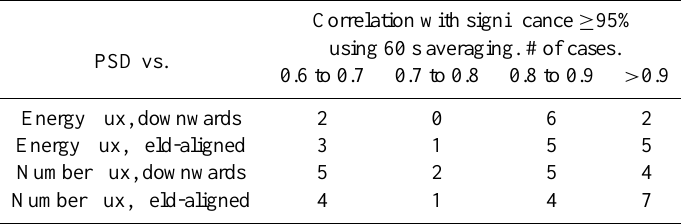
PSD of the electric field for three 1−minute intervals